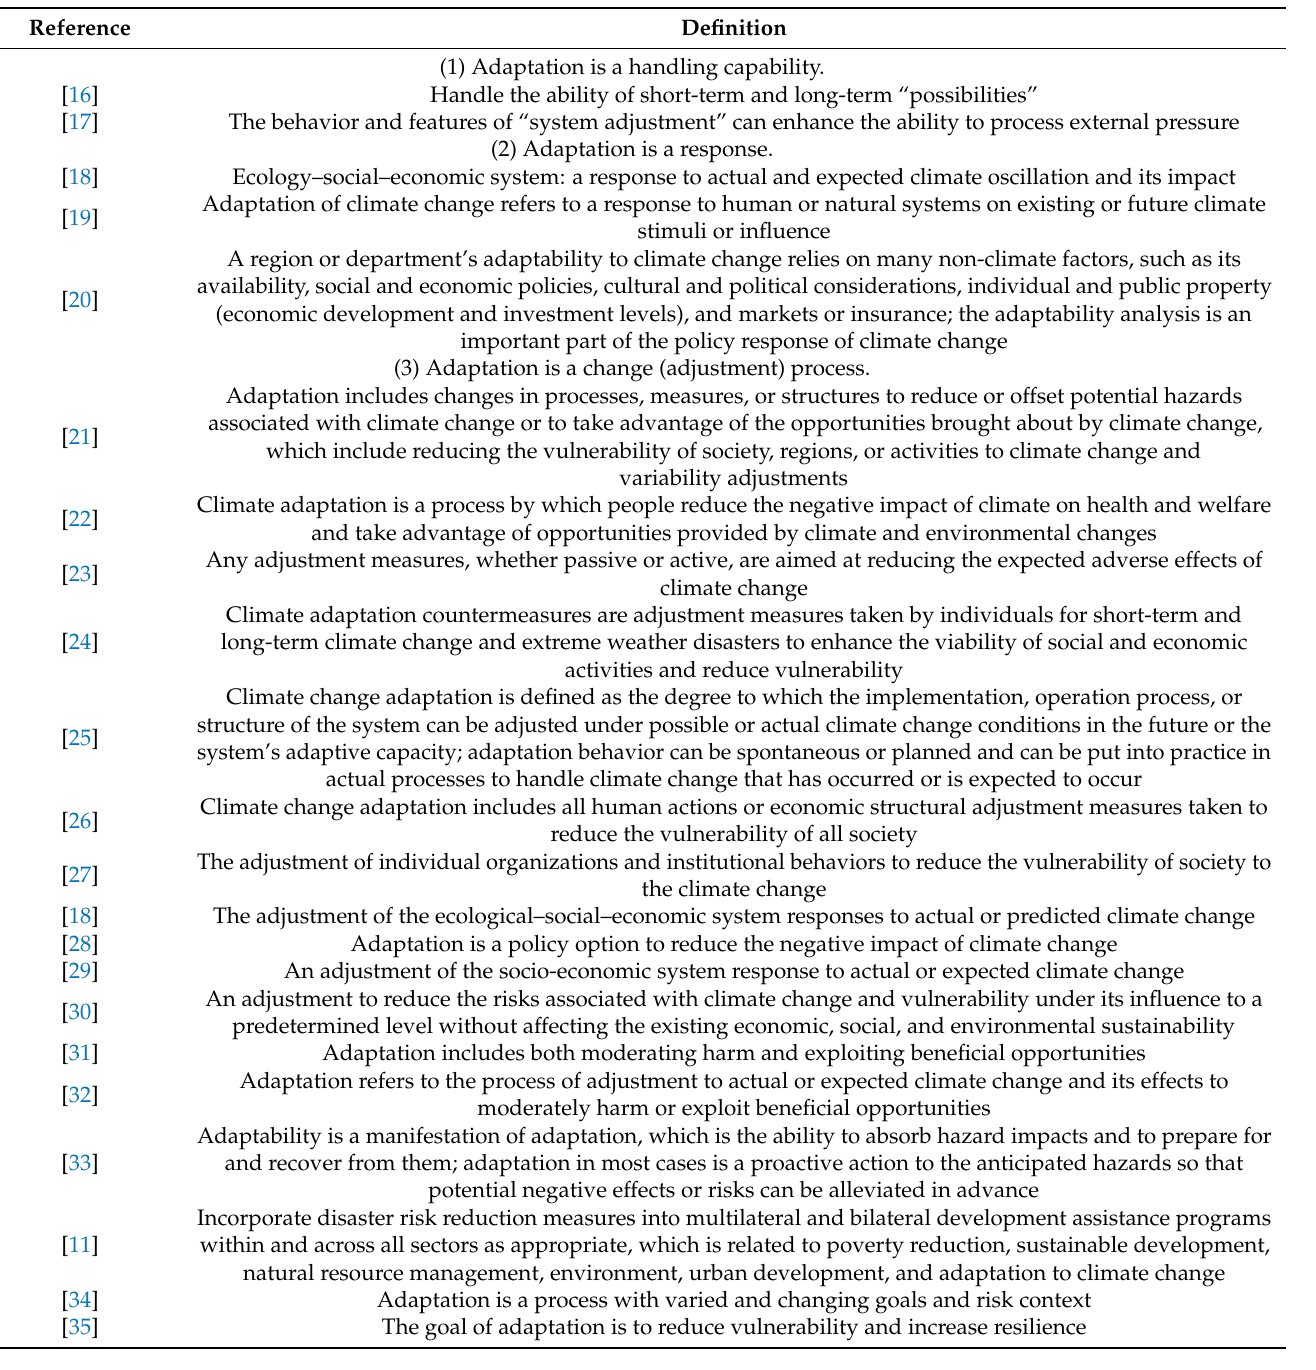
Table 1. Definition of